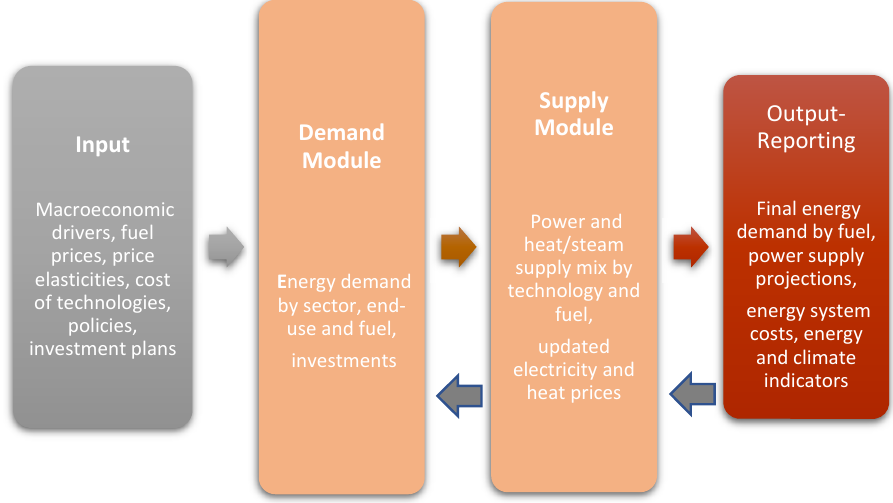
Figure 1 . Structure of E3 ‐ ISL energy system model. Figure 1. Structure of E3-ISL energy system